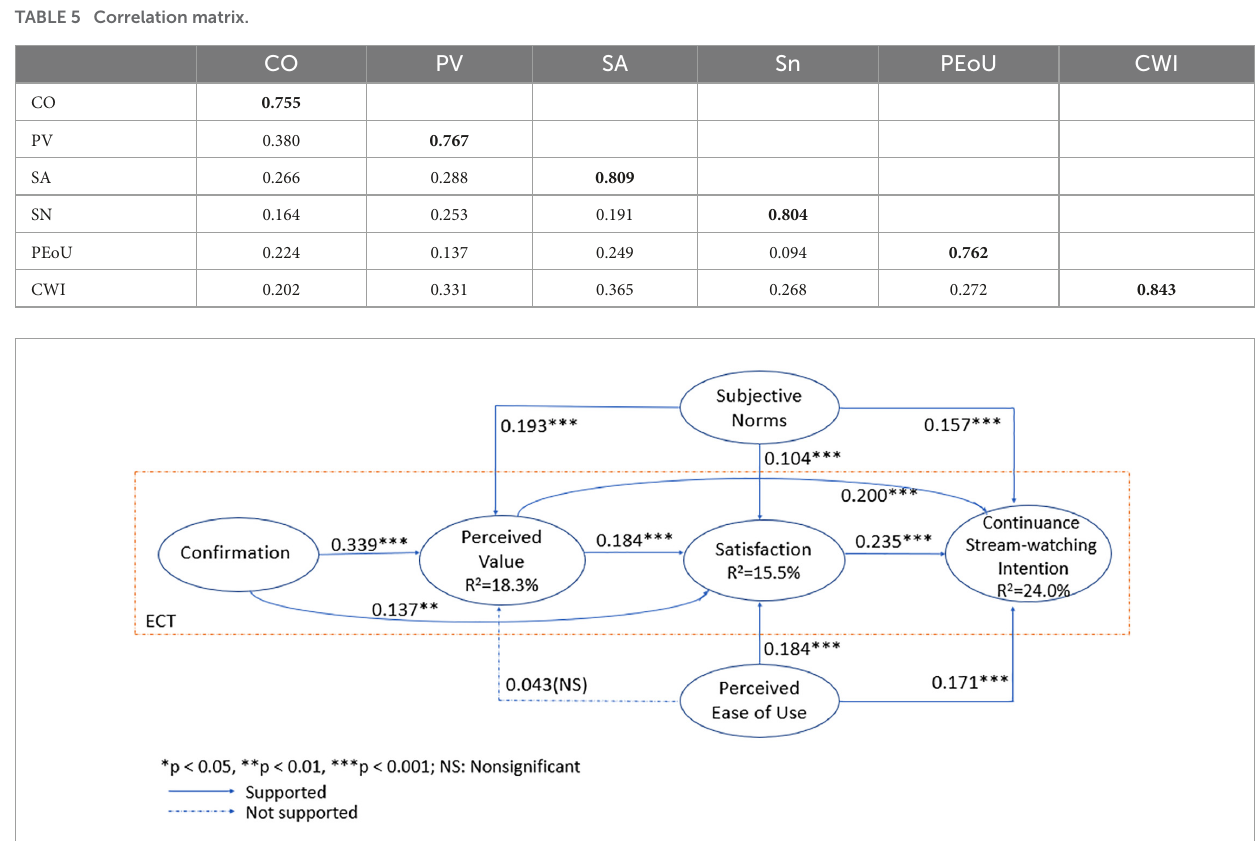
TABLE 5 Correlation matrix.